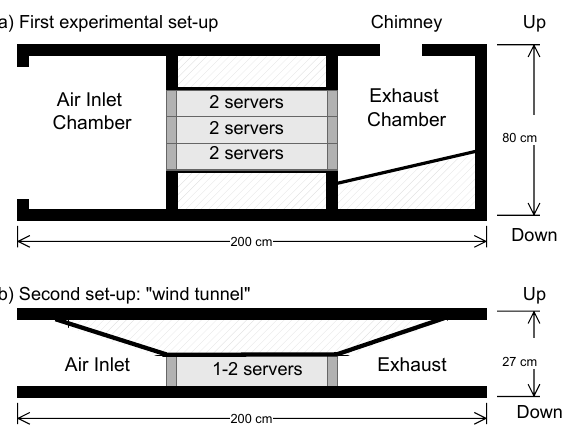
Figure 3. Two set-ups used in the scale-model experiments to investigate transfer learning between different hardware configurations: ( a ) wood box with a chamber that is heated by the exhaust air from a small server cluster, and ( b ) the central 2-meter section of a 5-meter-long wind